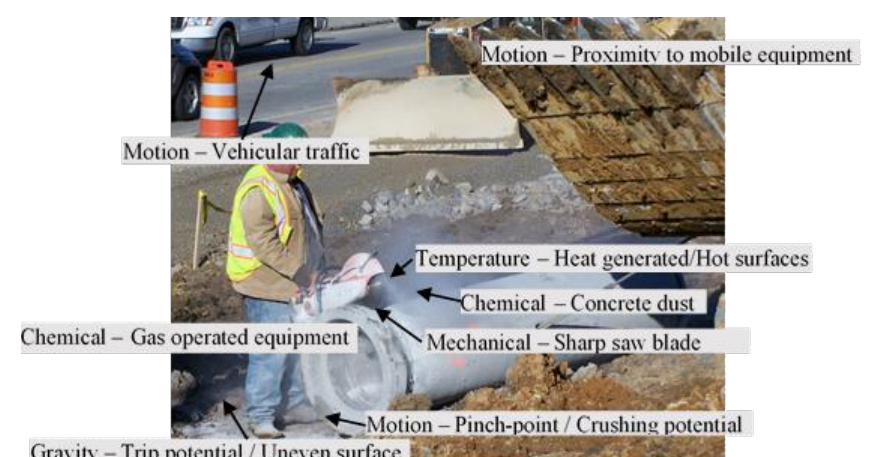
Figure 1. Example of a case image with pre-identified safety hazards.